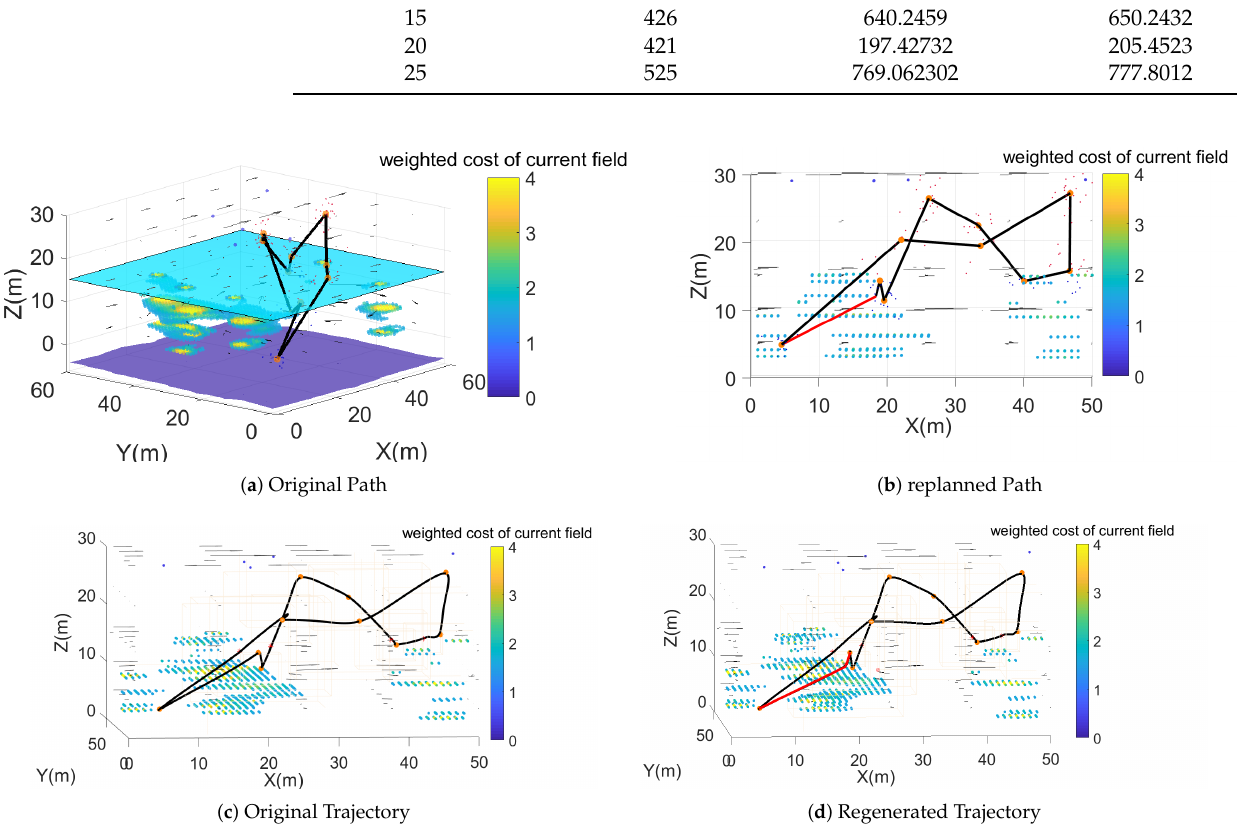
Figure 21. The replanned path and trajectory in current fields. The weighted costs of recorded strong currents fields are illustrated. The original path and trajectory passed through or quite near to (distance < vehicle length) strong current fields, which would be unsafe and involves a high energy cost. The replanned path and trajectory avoided such areas. The weighted cost of avoiding the current was 770.2315, and to not avoid it was 810.1669 in this